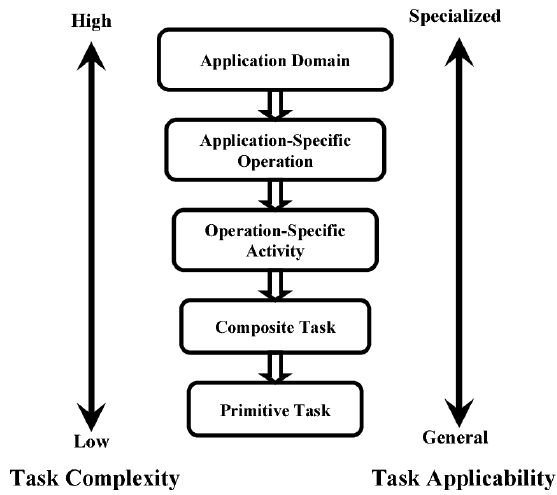
Figure 2. Taxonomy of tasks in an industrial context. Reprinted from [33].